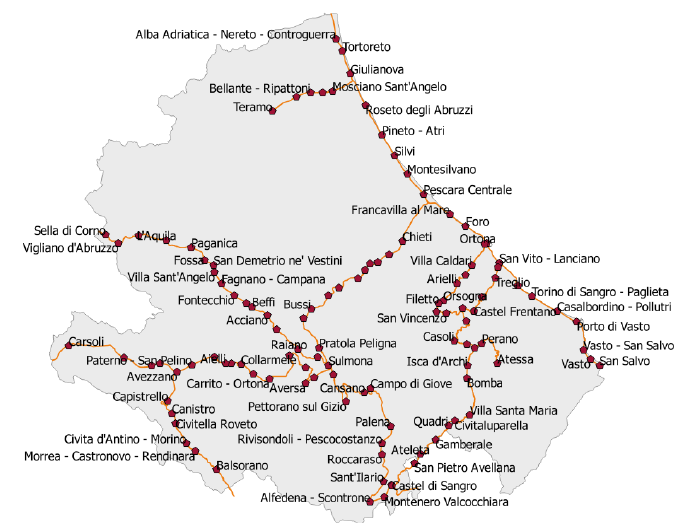
Figure 8. The railway stations along the railway lines of the Abruzzo